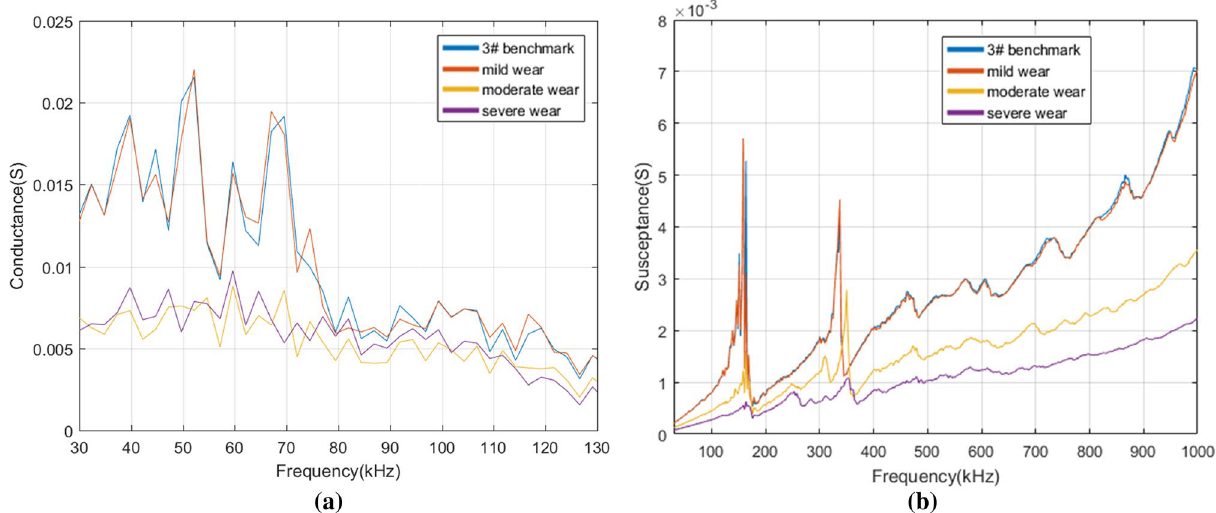
Figure 10. ( a ) The conductance and ( b ) the susceptance of 3# PZT under healthy and different wear conditions.